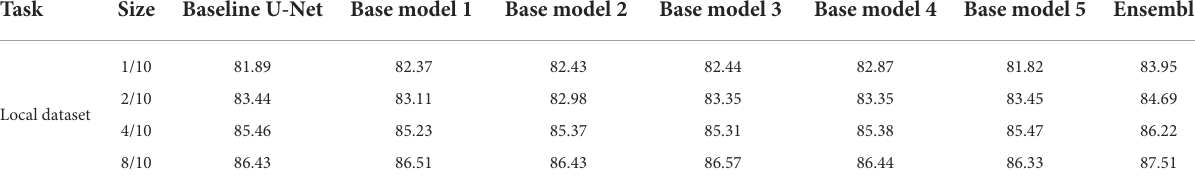
TABLE 5 Performance (Dice, %, higher is better) of SA-EN and baseline U-Net under different training set sample